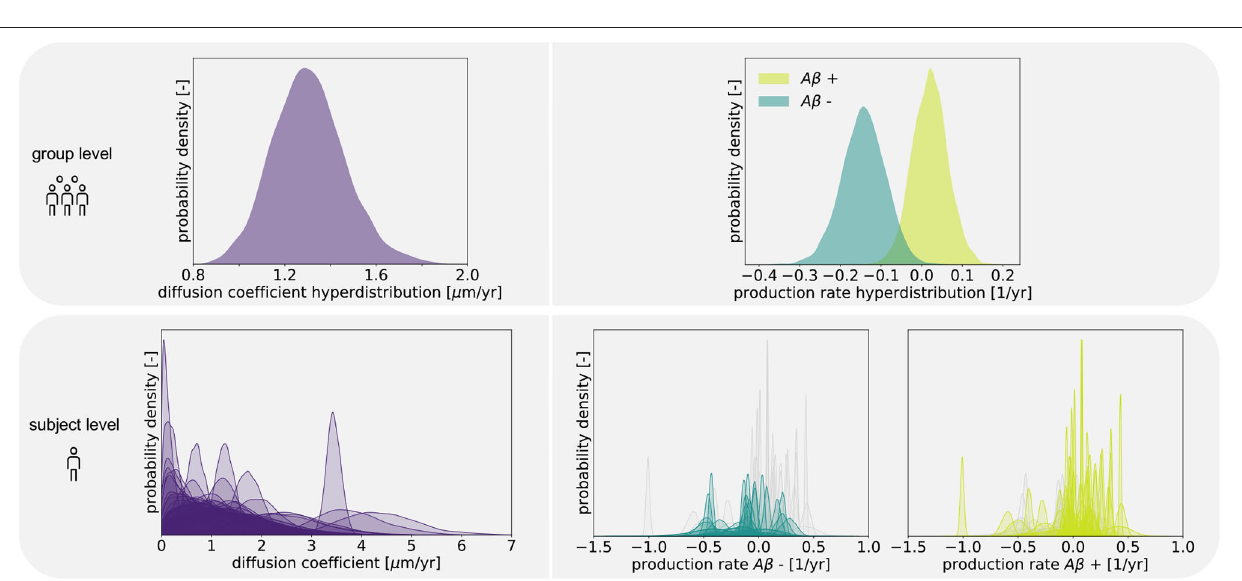
FIGURE 4 | Posterior distributions. Posterior distributions for diffusion coefficient and protein production rate on group and subject levels. Subject-wise distributions for the production rate are depicted in light and dark green in separate plots based on amyloid status. In each of those plots, the individual distributions associated with the other amyloid status group are depicted in light gray for